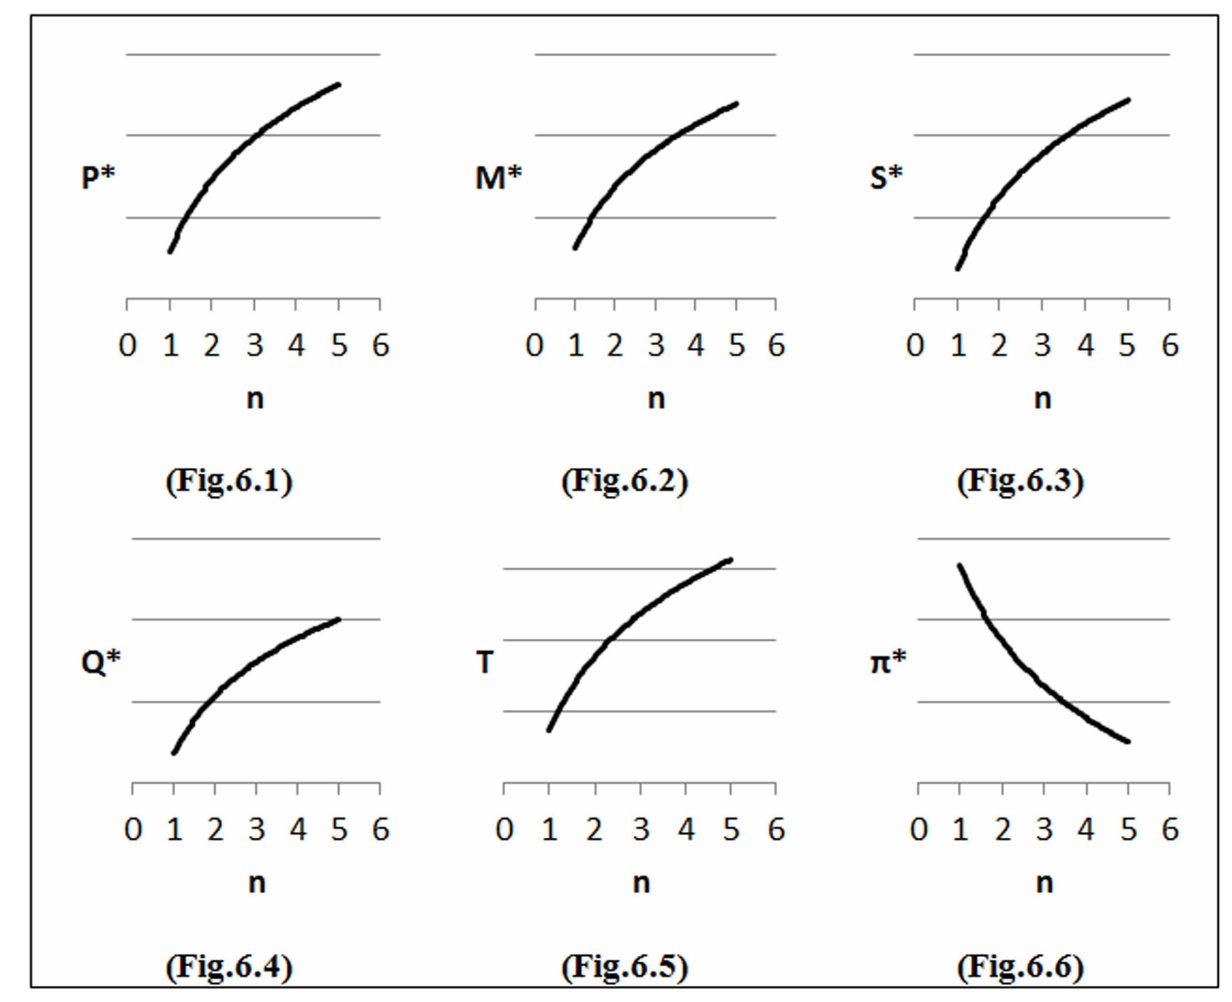
Fig 6. Effects of changes in ( a ) on decision